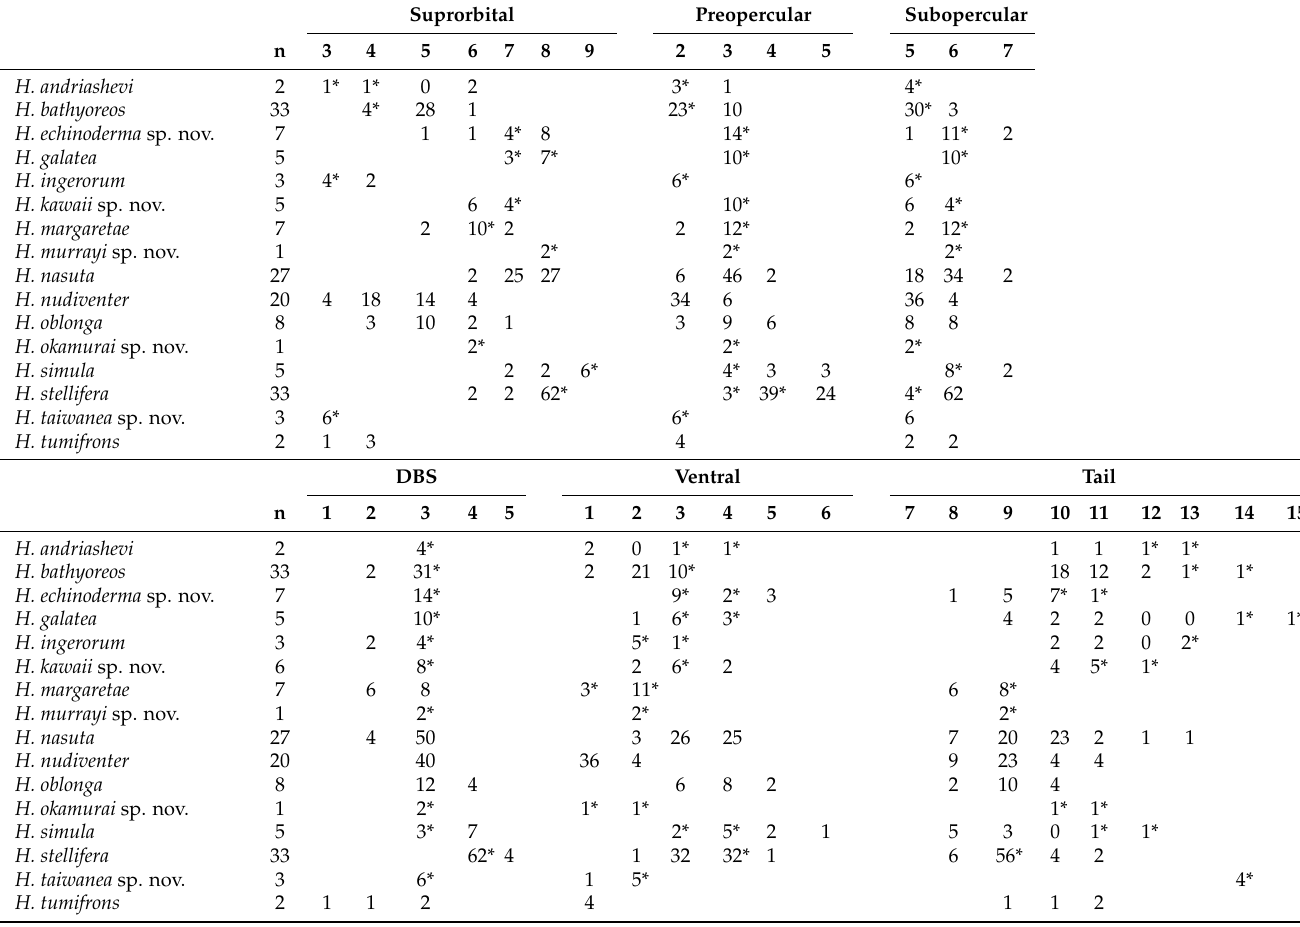
Table 2. Frequency of selected lateral-line neuromasts in all Halieutopsis species in present study. Most values are counted on both sides when available. * denotes value of holotype. DBS = Dorsal branch of